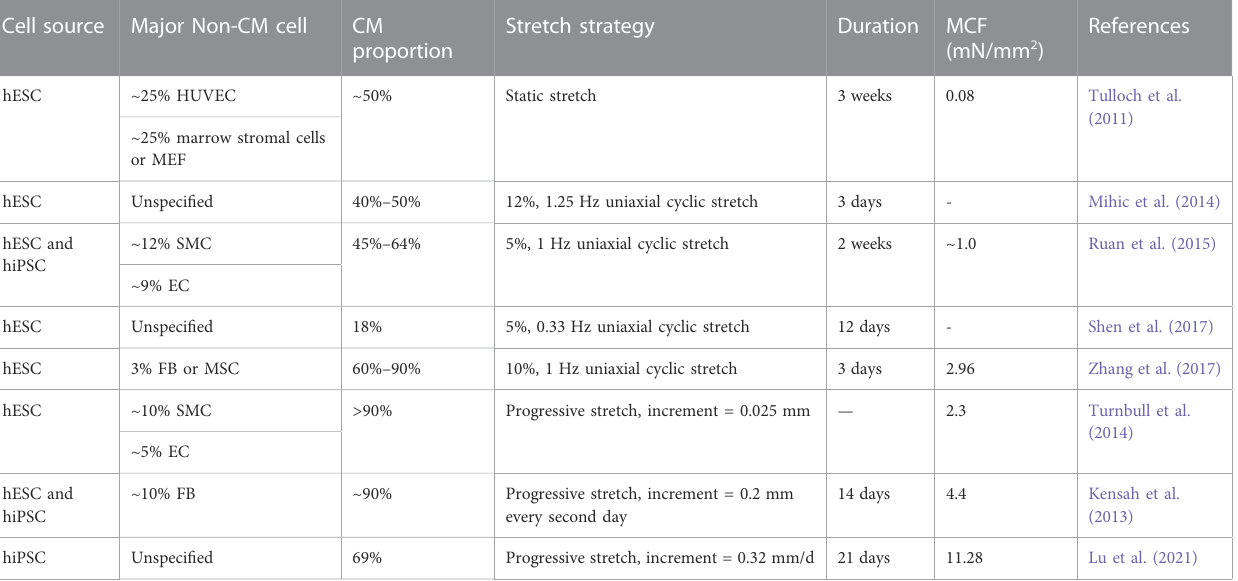
TABLE 2 Stretch strategies to promote SC-CM maturation.